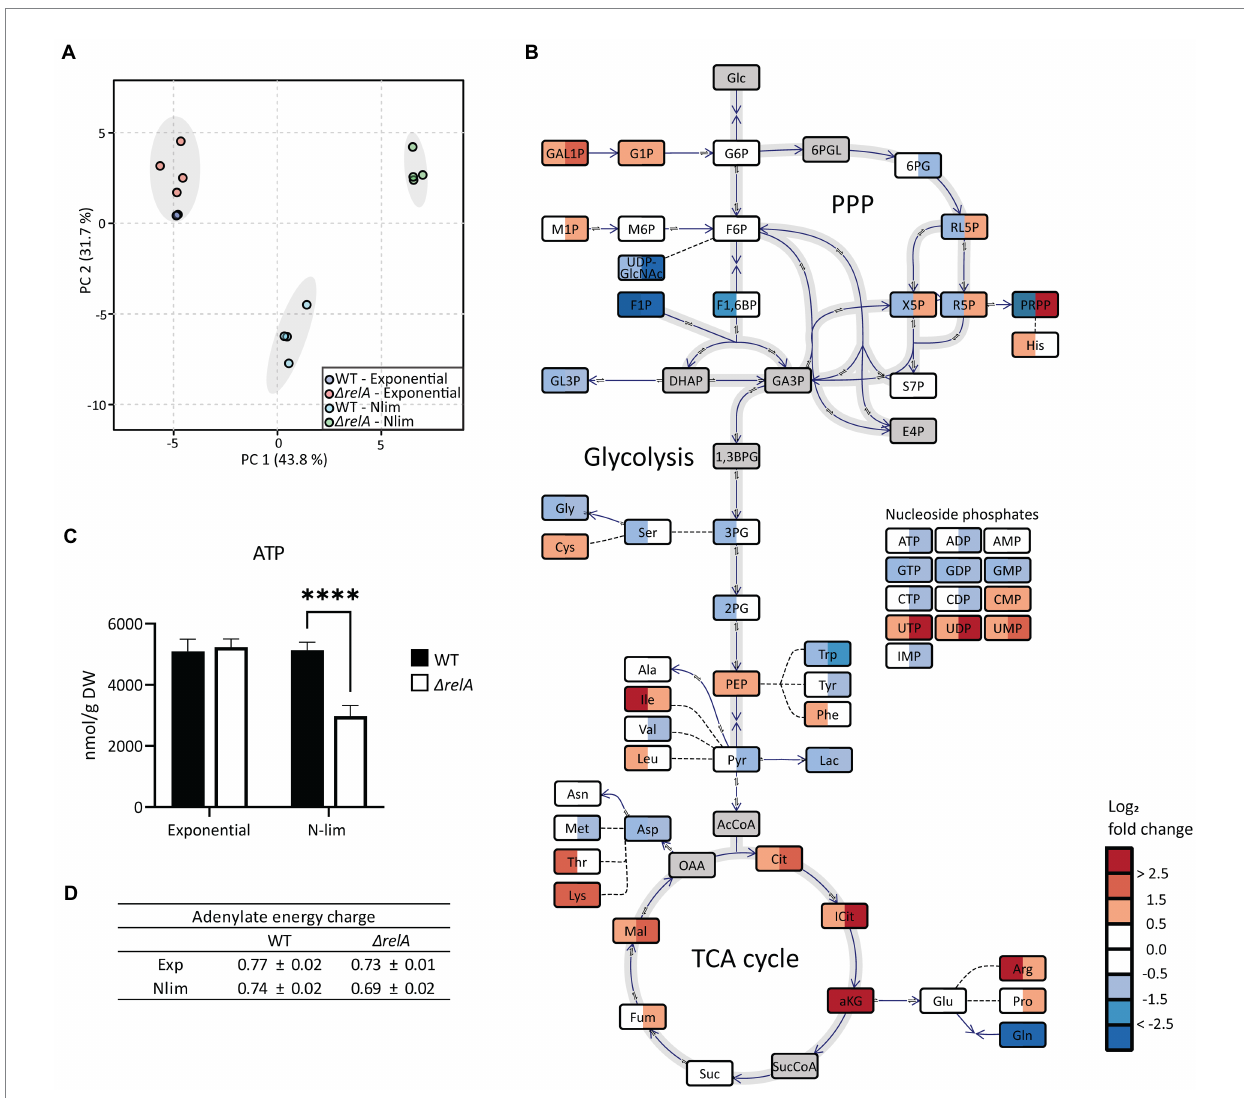
FIGURE 4 Metabolite profiling of E. coli WT and Δ relA in both exponential and nitrogen-limited stationary phases. Samples for metabolite profiling were taken directly from the bioreactor in exponential phase at OD600 = 3 or 20 min after entry to Nlim stationary phase. (A) Principal component analysis with 57 metabolites was performed with all samples, (B) log2 fold change in Nlim stationary phase relative to exponential phase. WT is to the left, Δ relA to the right in the boxes. Grey indicates not measured. The concentrations used to calculate the ratios are presented in Supplementary Table 1. (C) Absolute ATP concentrations, with unpaired, two-tailed t -test between each condition, n = 4. * p ≤ 0.05, ** p ≤ 0.01, *** p ≤ 0.001. (D) Adenylate energy charge (AEC), calculated using the absolute concentrations of ATP, ADP, and AMP, with n = 4. Metabolite abbreviations are presented in Supplementary Table